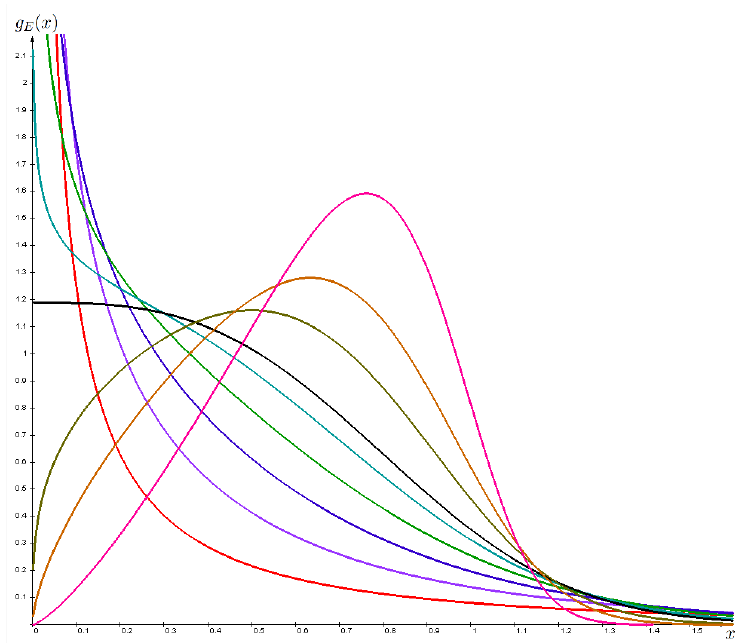
Figure 1. Gamma-exponential distribution densities for different values of